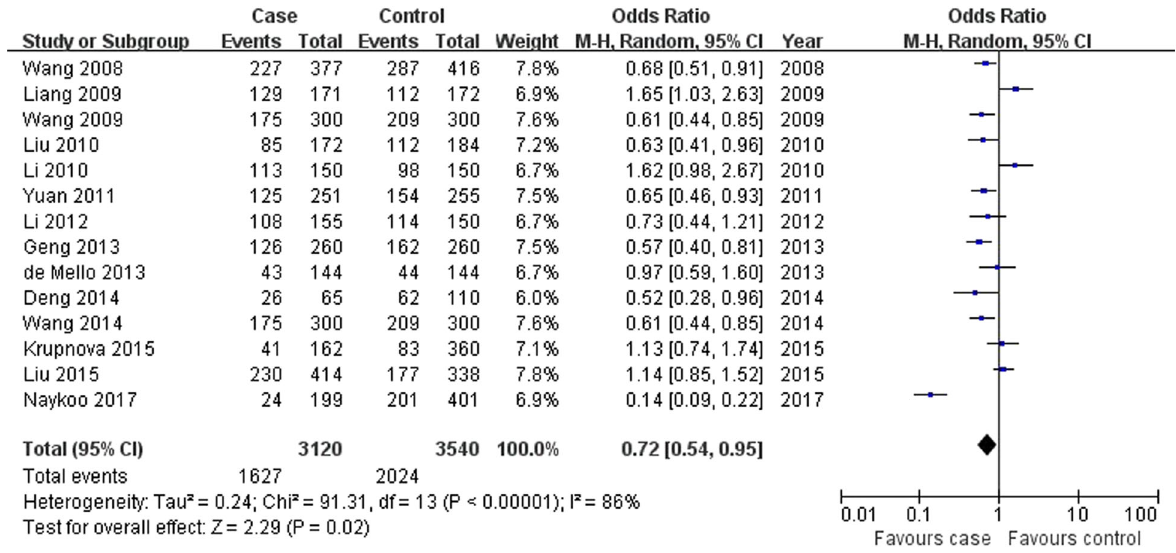
Table 2 Meta-analysis of the association of VEGF -2578C > A gene polymorphism with lung cancer risk Genetic contrasts Group and subgroups Studies number Q test